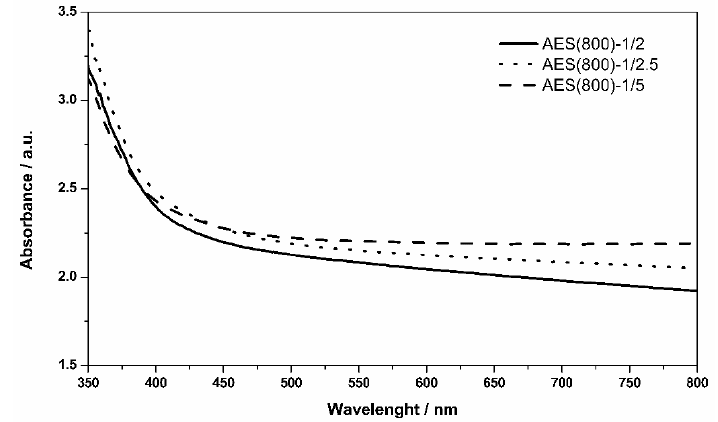
Figure 3. Absorption spectra of pure hybrid samples.